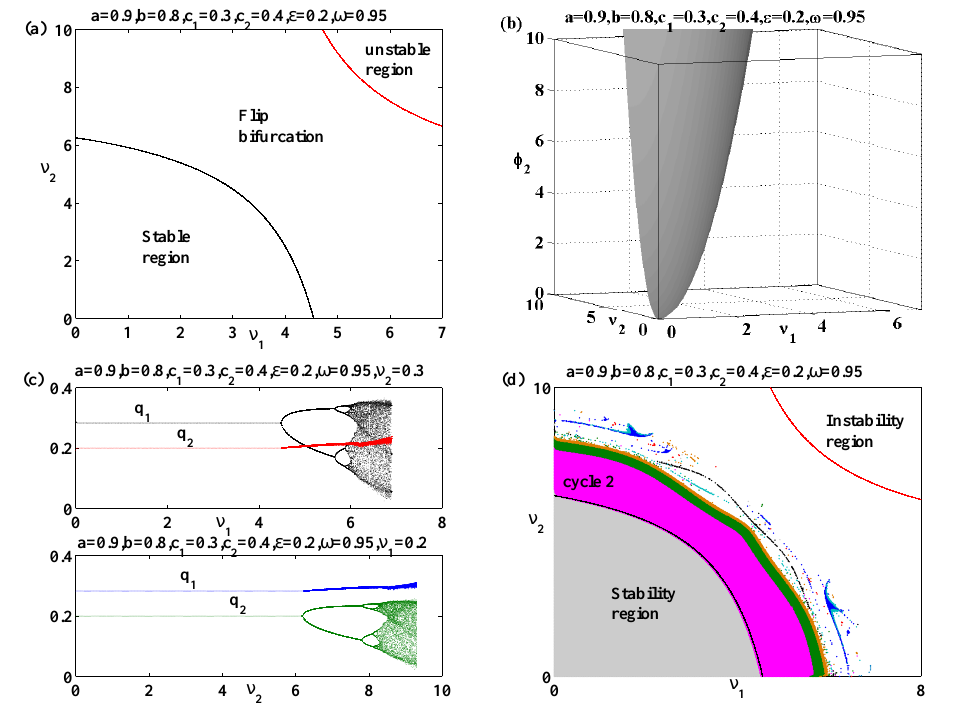
Figure 1. ( a ) Stability region of the Nash point in the ( ν 1 , ν 2 ) plane at: a = 0.9, b = 0.8, c 1 = 0.3, c 2 = 0.4, (cid:101) = 0.2 and ω = 0.95. ( b ) The value of φ 2 at: a = 0.9, b = 0.8, c 1 = 0.3, c 2 = 0.4, (cid:101) = 0.2, and ω = 0.95. ( c ) The 1D bifurcation diagrams with varying ν 1 and ν 2 . ( d ) The 2D bifurcation diagram on the ( ν 1 , ν 2 )